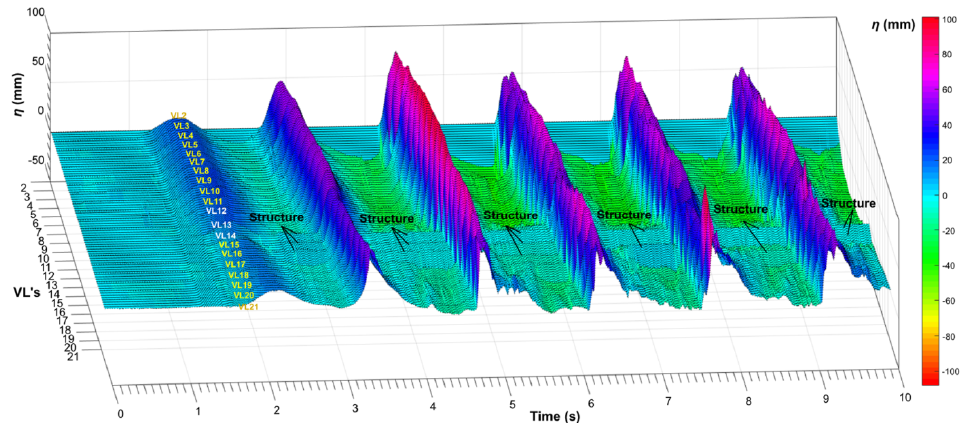
Figure 8. Spatio-temporal evolution of the vertical displacement of the detected levels ( η ) of the first six incident waves. The elevations are shown for the 21 virtual level probes (VLs) distributed along the entire horizontal domain of the image data, considering the time 0 < t < 10 s. The color bar in the right side indicates the magnitudes of the